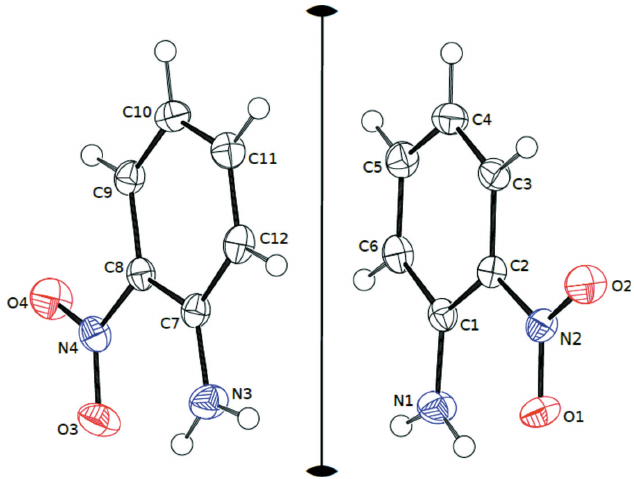
Figure 1 Molecular structure of the two independent molecules of (I) in the crystal. Displacement ellipsoids are drawn at the 50% probability level. Hydrogen atoms are drawn as small spheres of arbitrary radii. The molecules are related by a non-crystallographic twofold axis approxi- mately along a